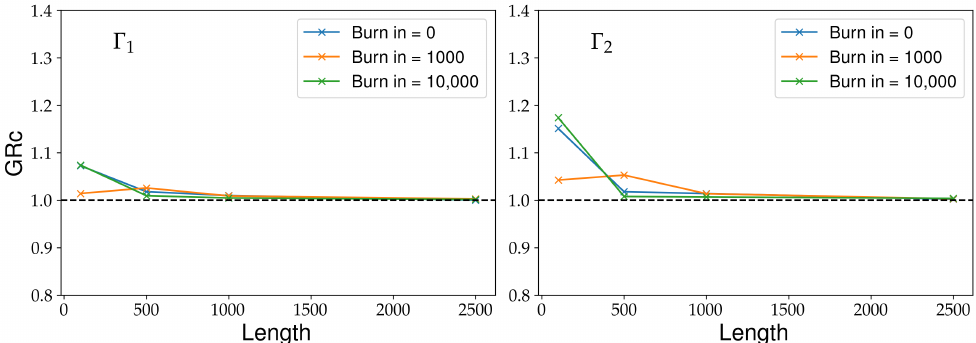
Figure 3. Gelmen–Rubin diagnostics for the case shown in Figure 2 for both Γ 1 ( left ) and Γ 2 ( right ). The Gelmen–Rubin coefficient 1, the black dashed line, shows the numerical convergence of the ≈ MCMC algorithm.